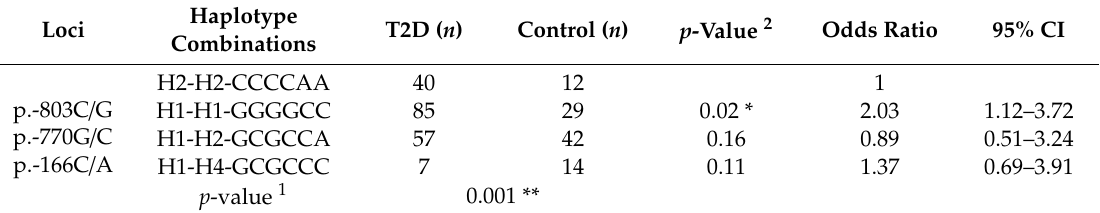
Table 2. Distribution di ff erences of the SIRT2 haplotype combinations and the risk of type 2 diabetes. Loci